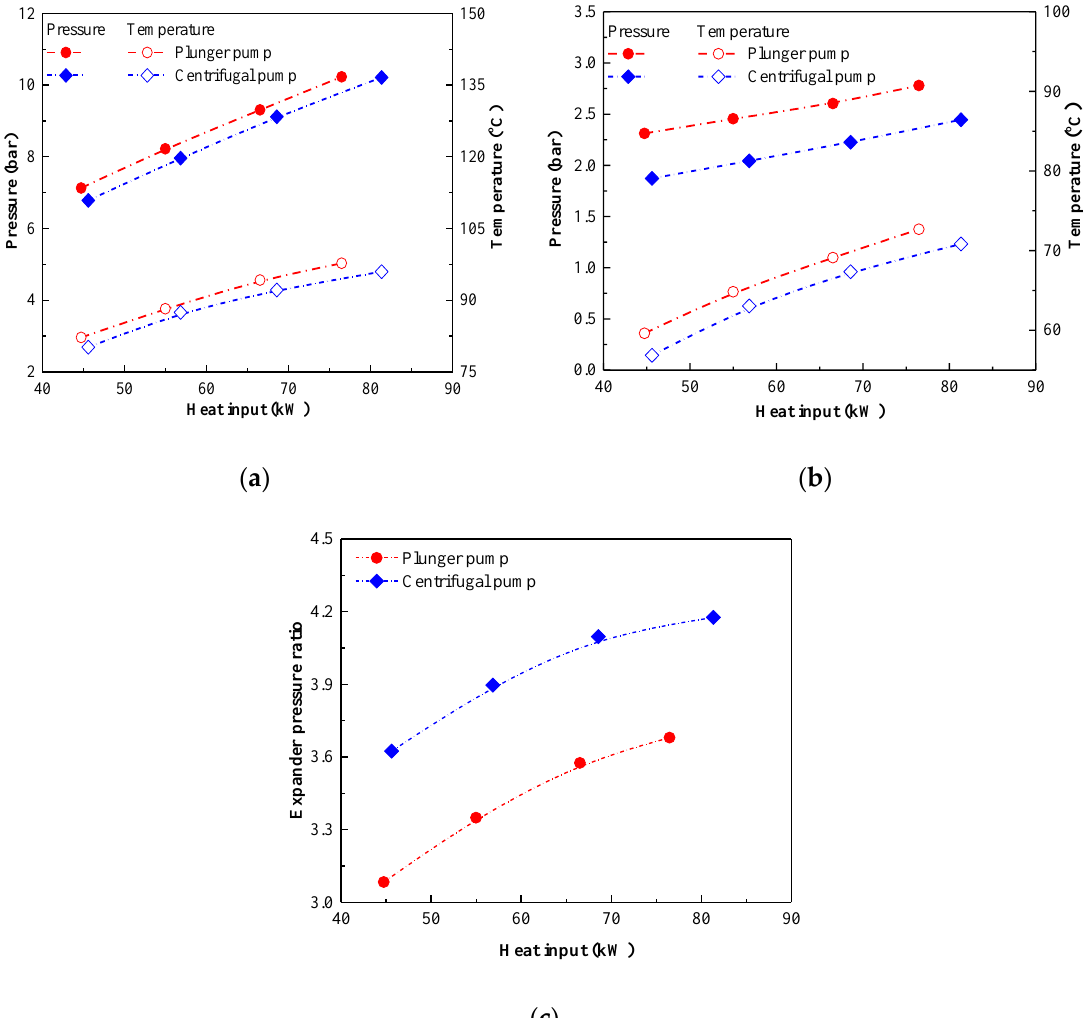
Figure 6. Temperature and pressure at the expander inlet and outlet with heat input using the plunger pump and centrifugal pump: ( a ) pressure and temperature at the expander inlet; ( b ) pressure and temperature at the expander outlet; ( c ) expander pressure ratios.